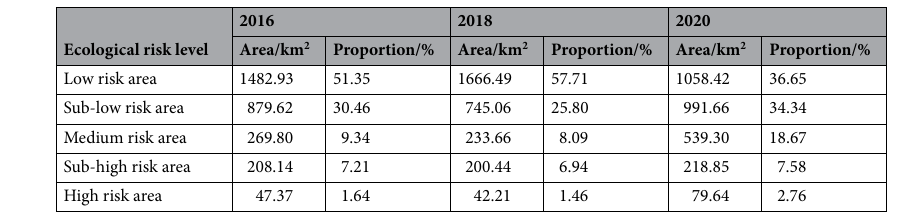
Table 5. Changes in the ecological risk level areas along the highway from 2016 to